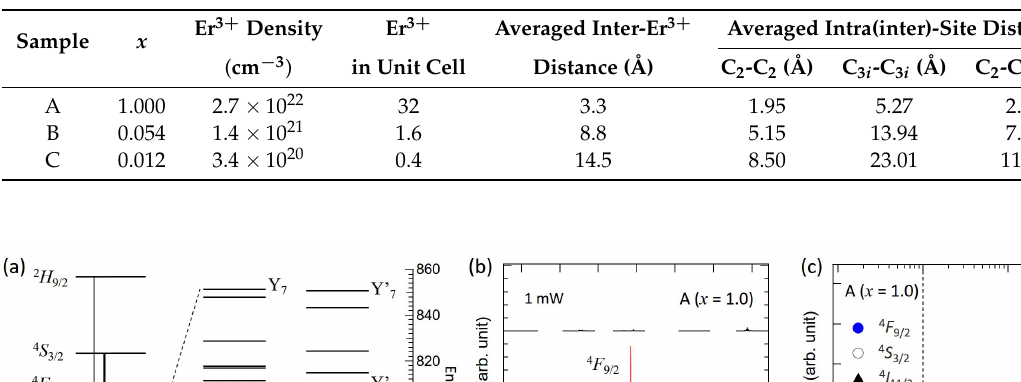
Table 1. Summary of the studied (Er x Sc 1 − x ) 2 O 3 samples. The averaged distances are evaluated from the lattice constant and Er concentration.